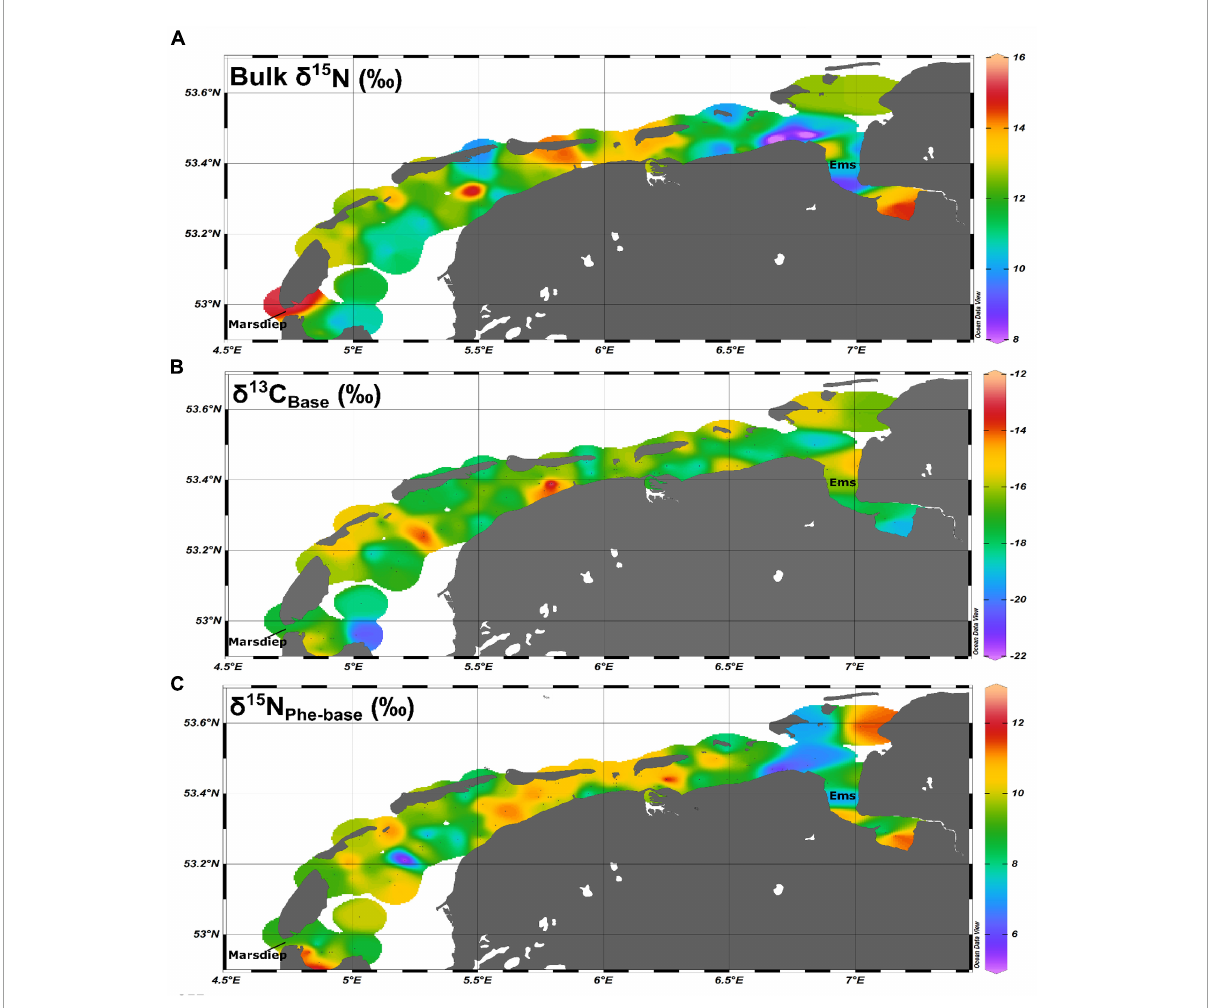
FIGURE1 Spatial coverage for (A) regionally adjusted bulk δ 15 N values, (B) δ 13 C Base values, and (C) δ 15 N Phe − base values for the Dutch Wadden Sea.